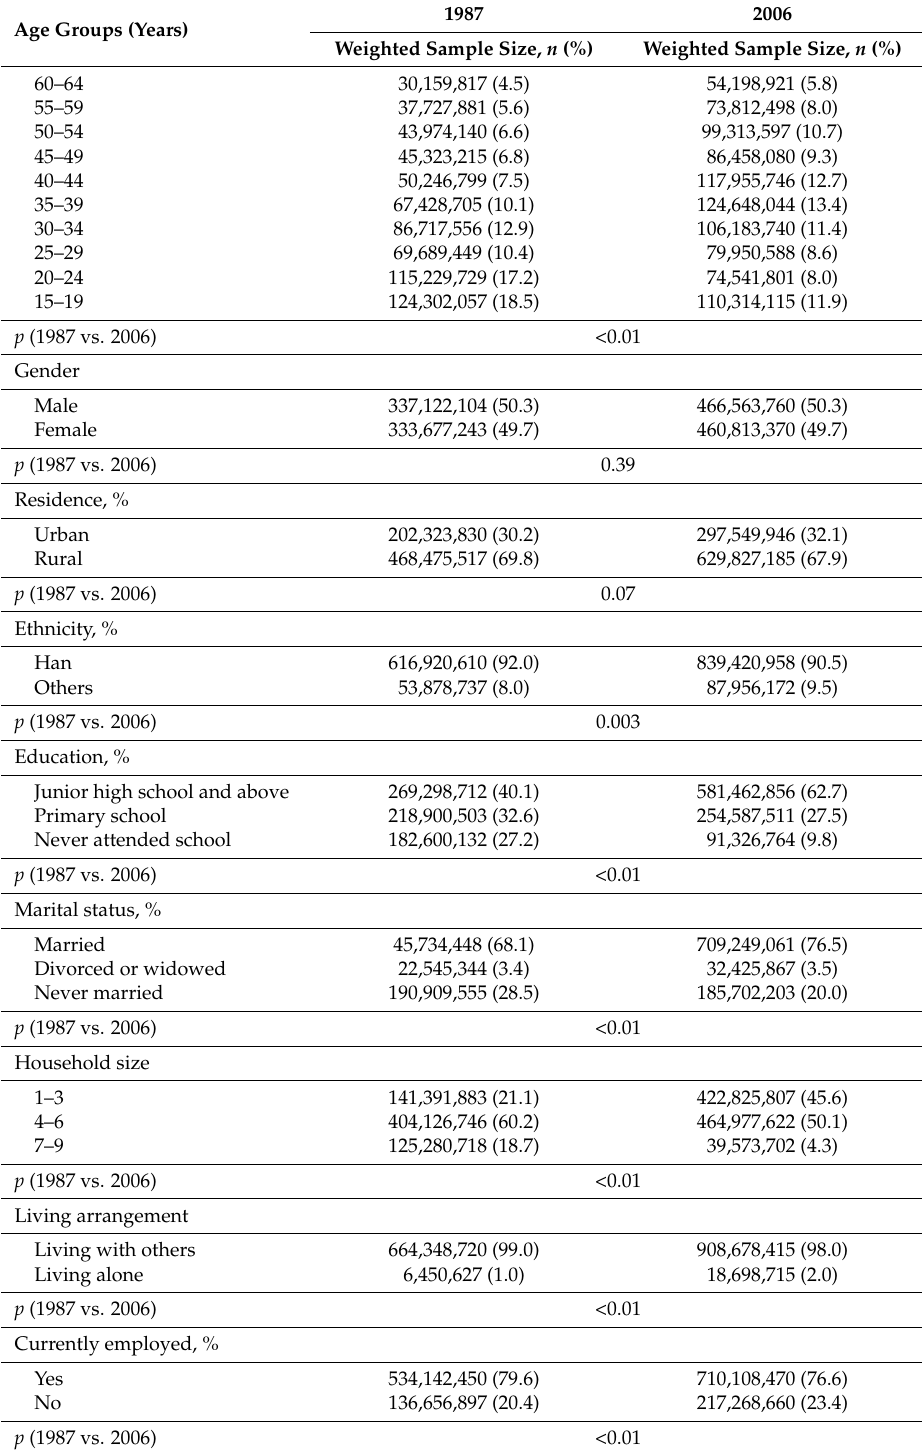
Table 2. Characteristics of the weighted national survey population a